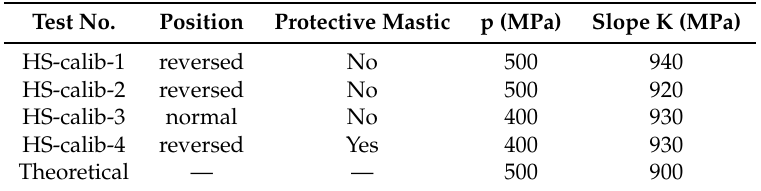
Figure 9. HS calibration test concept and results: ( a ) normal; and ( b ) reversed set. Table 3. Description of the HS calibration test: sample/cap arrangement, condition, pressure applied and bulk modulus